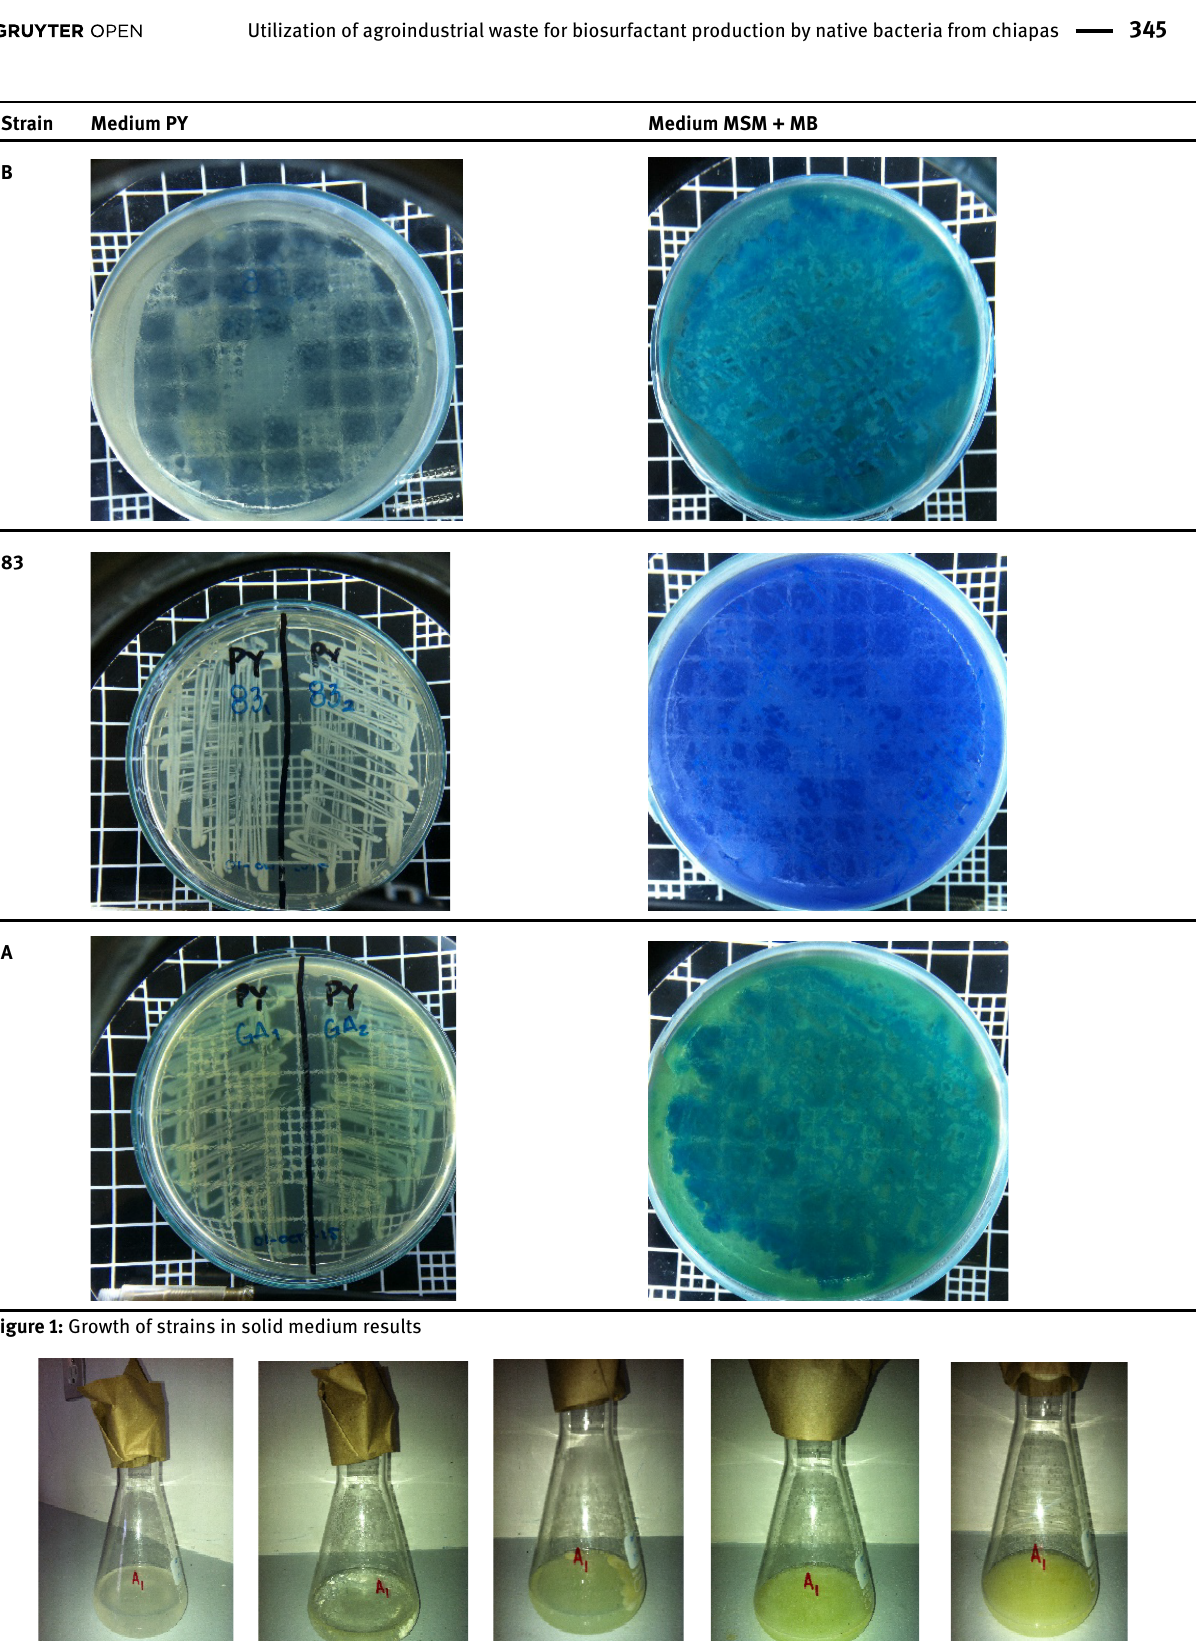
Figure 2: Variation in the SMM aspect during the BS production of the strain